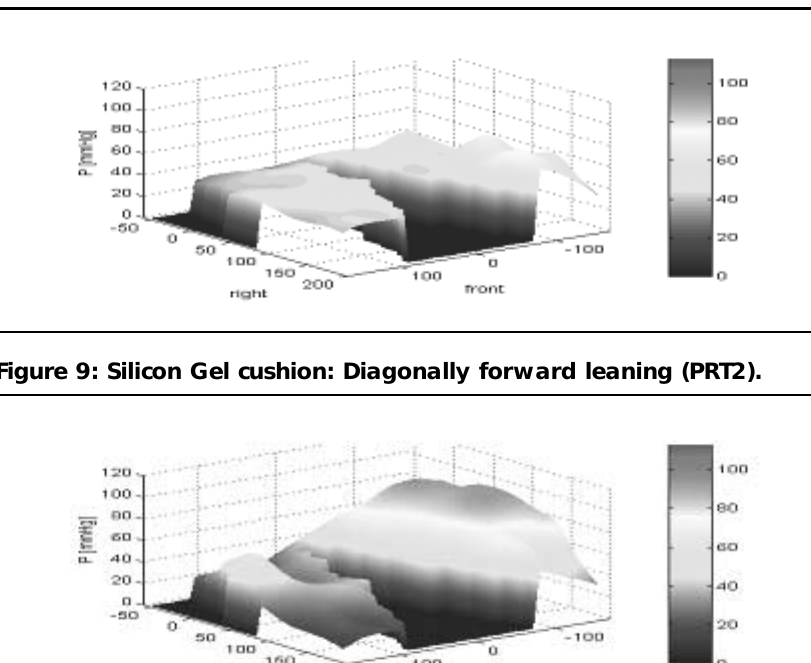
Figure 8: Silicon Gel cushion: Forward leaning (PRT1).